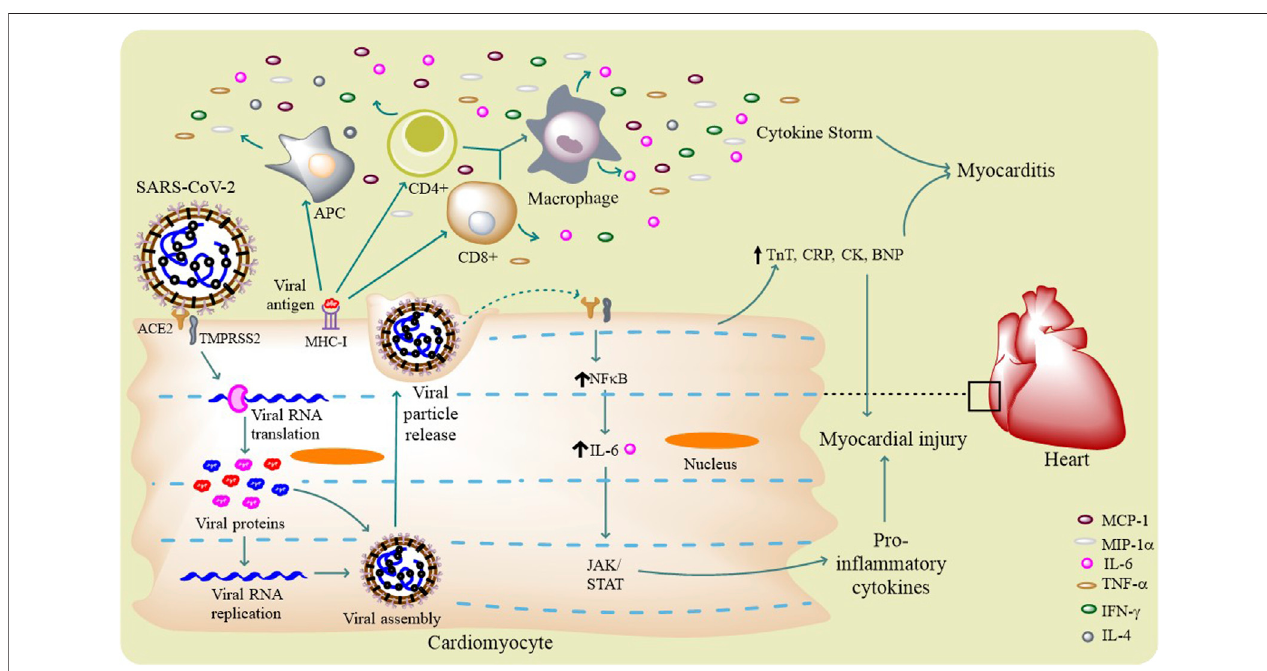
FIGURE3| SARS-CoV-2lifecycleandcardiovascularcomplications:SARS-CoV-2infectsahostcellthroughACE2andTMPRSS2,andthroughitsintracellularlife cycleitproducesanumberofnewvirions.Thevirusactivatesdifferentinnateandadaptiveimmunecells(APCsandTcells)toreleasecertainpro-in fl ammatorymolecules like IL-6, IFN- γ , TNF- α , and MCP-1 that results in cytokine storm. This surge in immunomodulatory molecules mediates the occurrence myocarditis. Virus itself can induce the host cell to produce pro-in fl ammatory cytokines through IL-6 – mediated JAK/STAT and NF- κ B pathways. Few circulating biomarker proteins like TnT, CRP, CK, and BNP can potentially cause myocardial